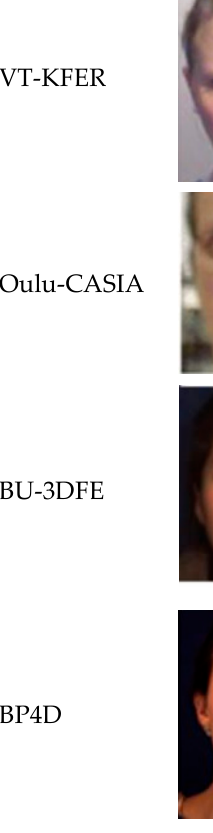
Figure 4. Twenty different datasets for facial emotion recognition, including CK+, MMI, JAFFE, SFEW, KDEF, FER-2013, MUG, Yale B face, BOSPHORUS, UvA-Nemo, NUST-NVIE, SPOS, FEI, DIFSA, AFEW, Curtain-face, VT-KFER, Oulu-CASIA, BU-3DFE and BP4D.